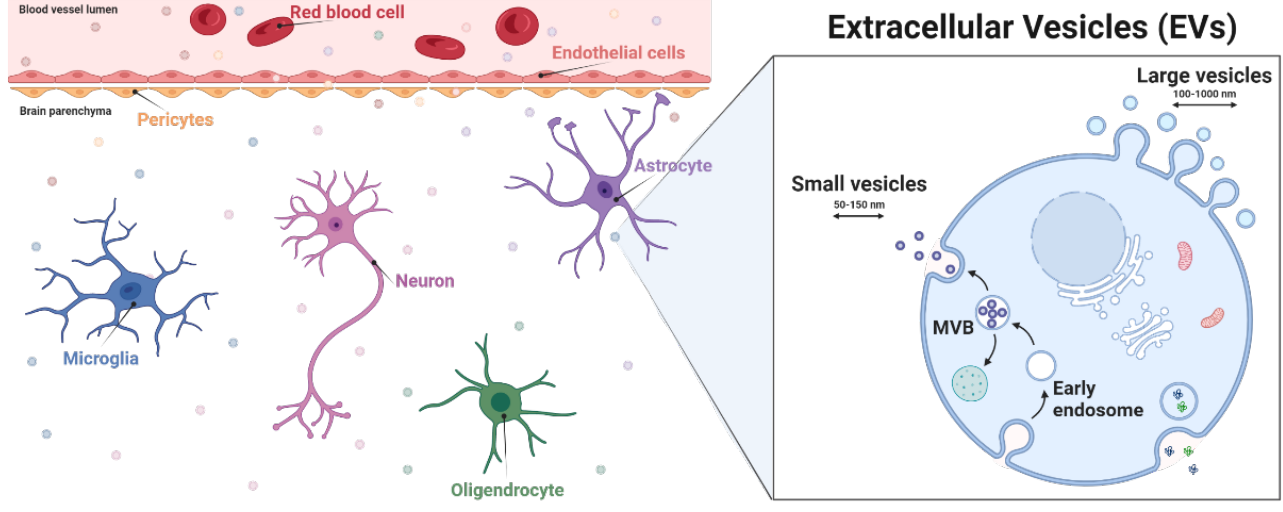
Figure 1. Extracellular vesicles in the neurovascular unit environment. Neurovascular unit components are represented such as brain endothelial cells, pericytes, astrocytes, microglia, oligodendrocytes, and neurons. Extracellular vesicle biogenesis representation. Figure created with BioRender.com (accessed on the 26 August 2022).